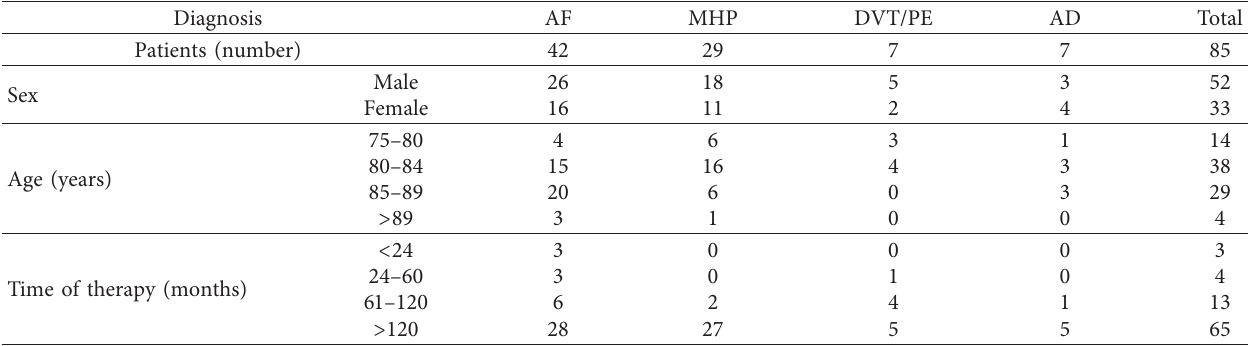
Table 1: Characteristics of patients according to the